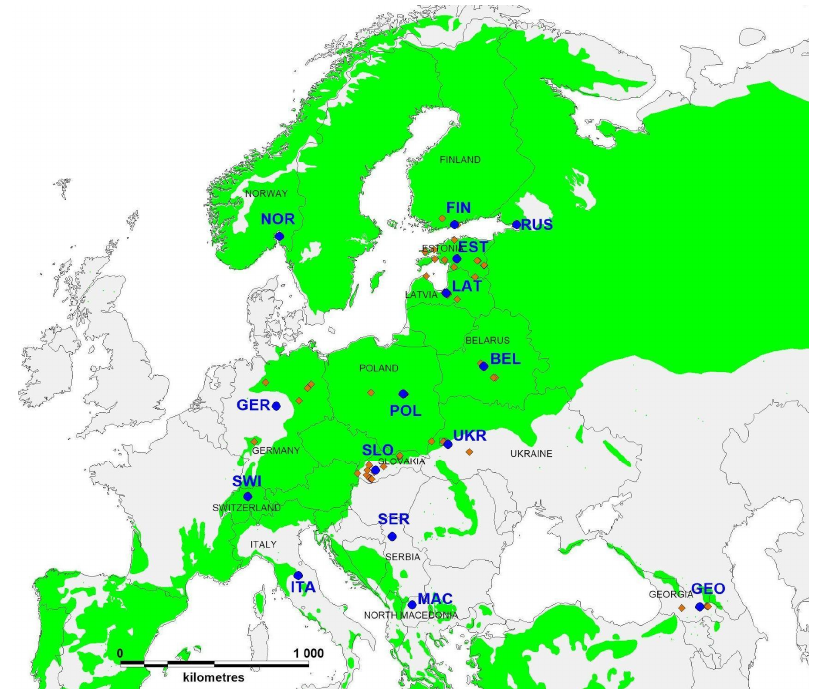
Figure 1. Map of sampling sites of Diplodia sapinea . Green shading indicates the distribution of the genus Pinus in Europe [49]. Red symbols indicate sampling sites (where several sites/countries were sampled); blue symbols indicate subpopulations and weighted geographical midpoints of sampling sites. Subpopulations are coded according to countries as follows: Belarus—BEL, Estonia—EST, Fin-